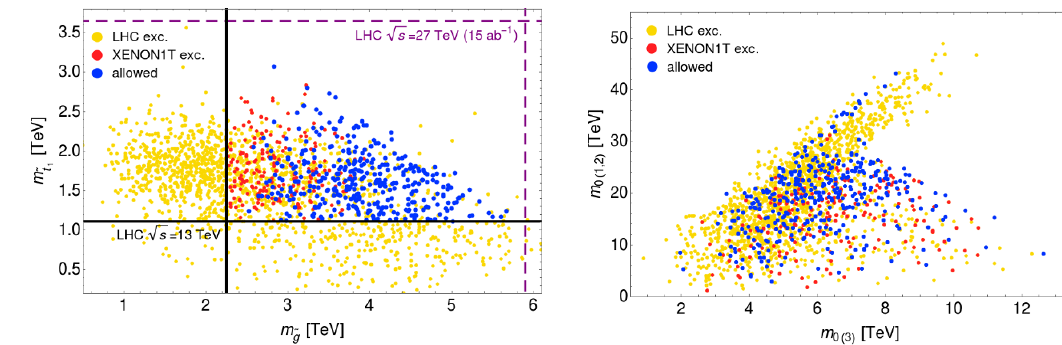
Figure 6. Locus of n = 1 landscape scan points for the NUHM3 model with (cid:22) = 100{360 GeV in the m ~ vs. m ~ g plane versus recent LHC Run2 t 1 constraints (black) and projected HE-LHC 95% CL reach contours (purple-dashed).